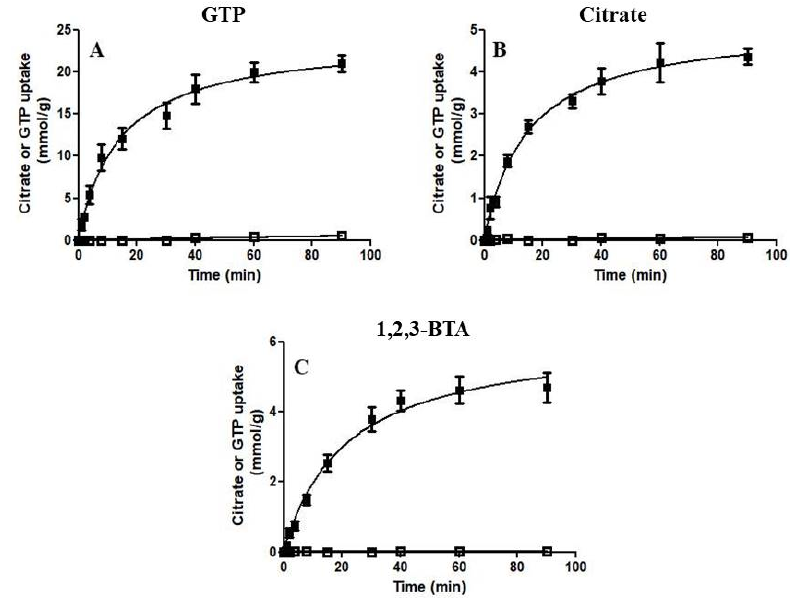
Figure 4. Time courses of [8- 3 H] GTP ( ■ ) and [1,5- 14 C] citrate ( □ ) uptake in proteoliposomes reconstituted with the recombinant Ggc1p. 1 mM [8- 3 H] GTP or 1 mM of [1,5- 14 C] citrate was added to proteoliposomes containing internal 5 mM GTP (panel ( A )), 5 mM citrate (panel ( B )) or 5 mM 1,2,3-BTA (panel ( C )).